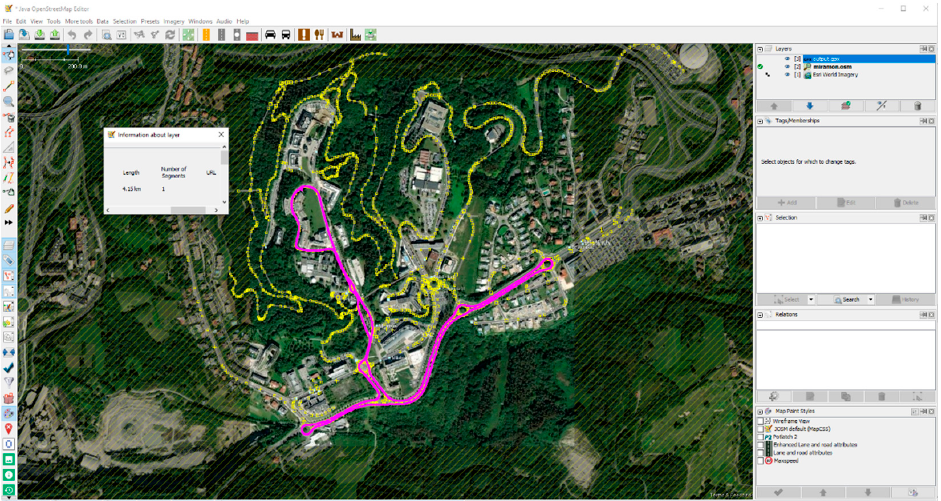
Figure 8. Satellite image visualisation using JOSM including a GPS trace of the route performed during our test drive and the associated OSM map file.